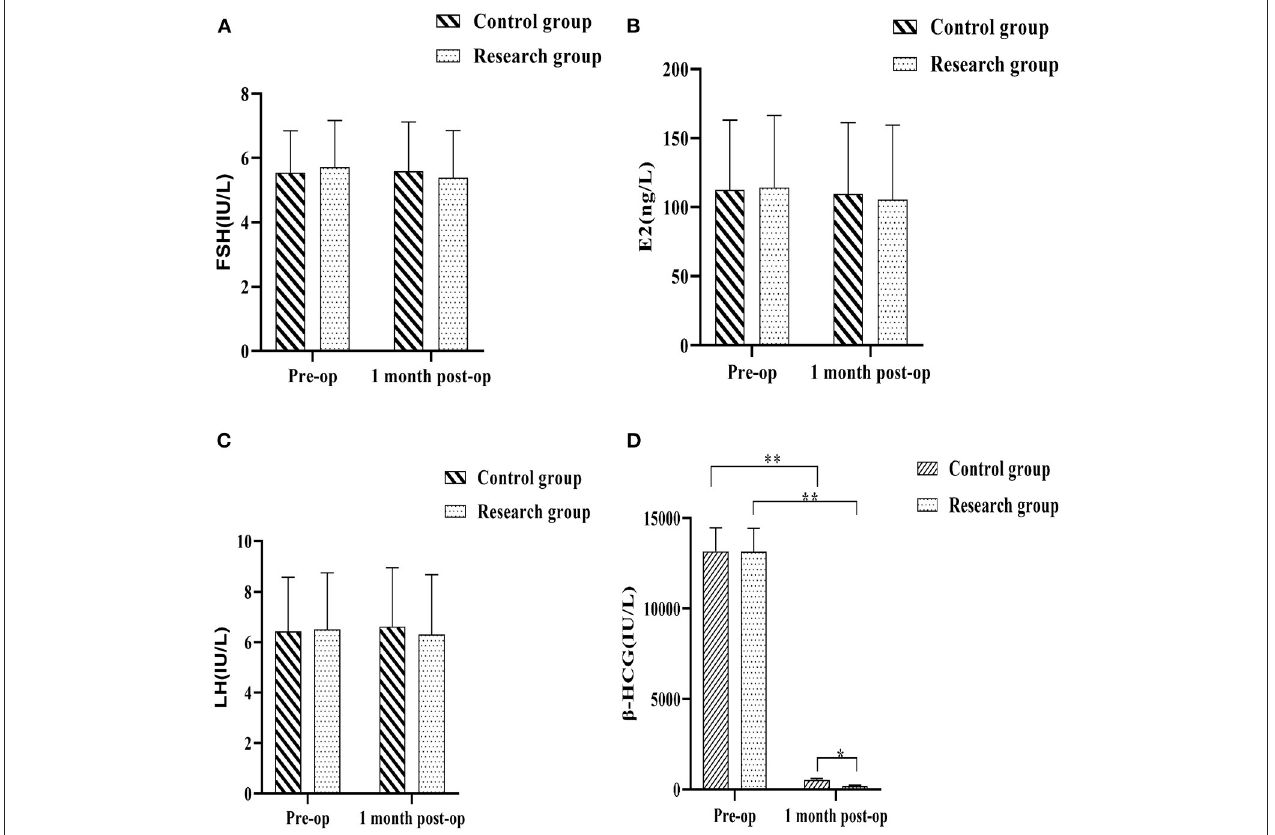
FIGURE 3 | Comparison of reproductive hormone levels between the two groups before and 1 month after surgery. (A) follicle stimulating hormone (FSH); (B) estradiol (E2); (C) luteinizing hormone (LH); (D) Human chorionic gonadotropin ( β -HCG). Comparison between the two groups over the same period, * P < 0.05; compared with the same group pre-op, ** P <